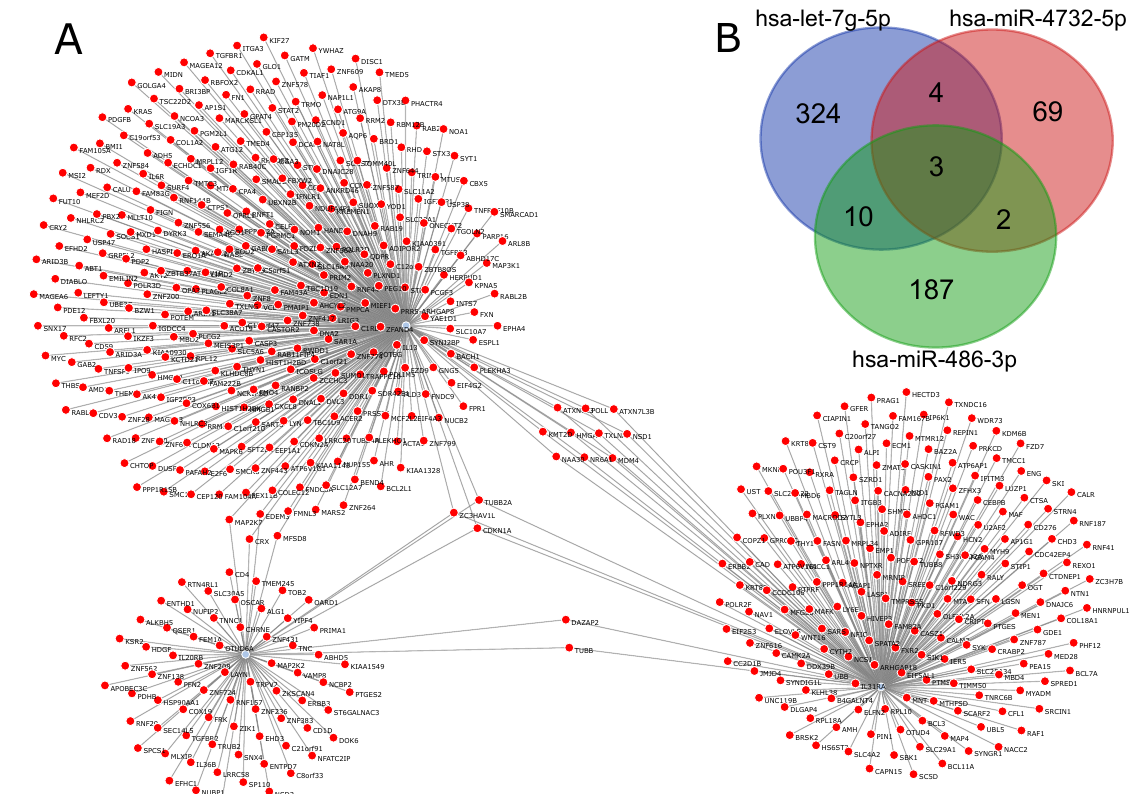
Figure 5. miRNA–gene network for TP vs. HC generated by ncRNA-network tool: ( A ) miRNA–gene network for the three DEmiRNAs ( hsa-miR-4732-5p , hsa-miR-486-3p and hsa-let-7g-5p ); and ( B ) Venn diagram indicating intersections between genes for each